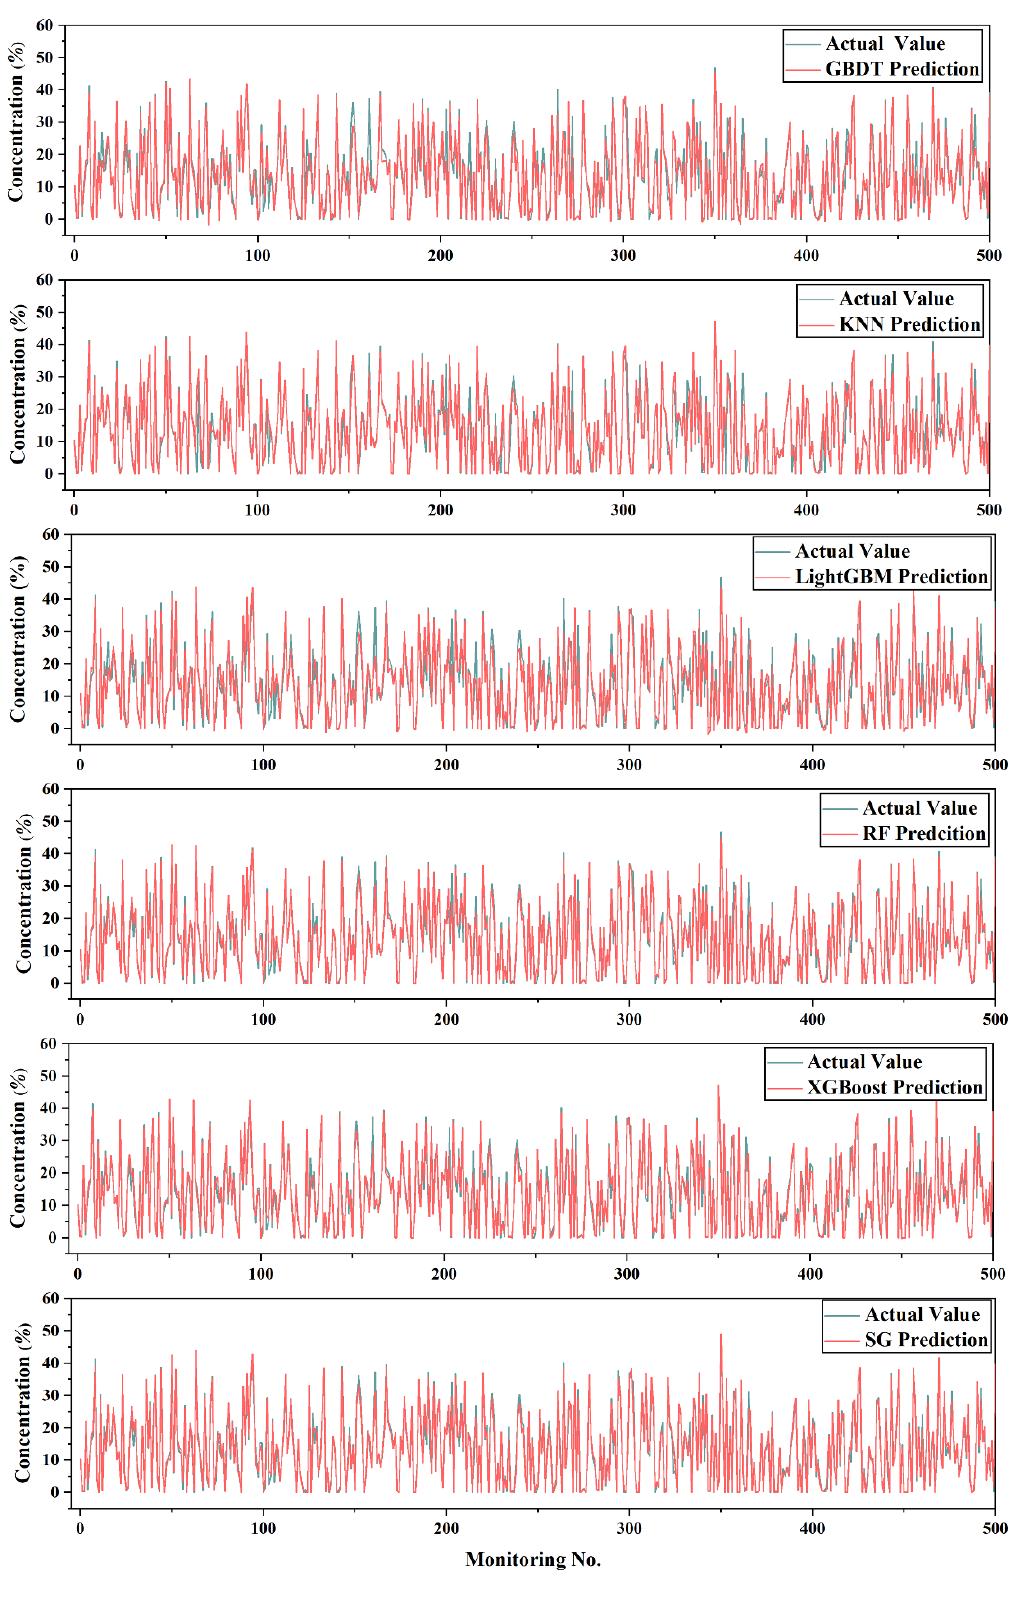
Figure 7. Error comparison.